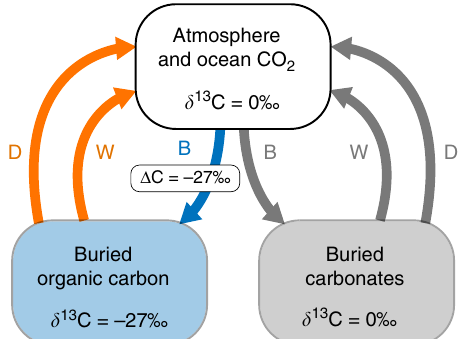
Fig. 2 The long-term carbon cycle. The cycle is composed of fl uxes between atmospheric and oceanic carbon, organic carbon and carbonate. Carbon is moved from the atmosphere and ocean to the crust through burial (B), with weathering (W), degassing and metamorphism (D) offering mechanisms by which carbon is returned to the ocean/atmosphere system. Oxygen are displayed as grey. Fractionation of buried organic carbon relative